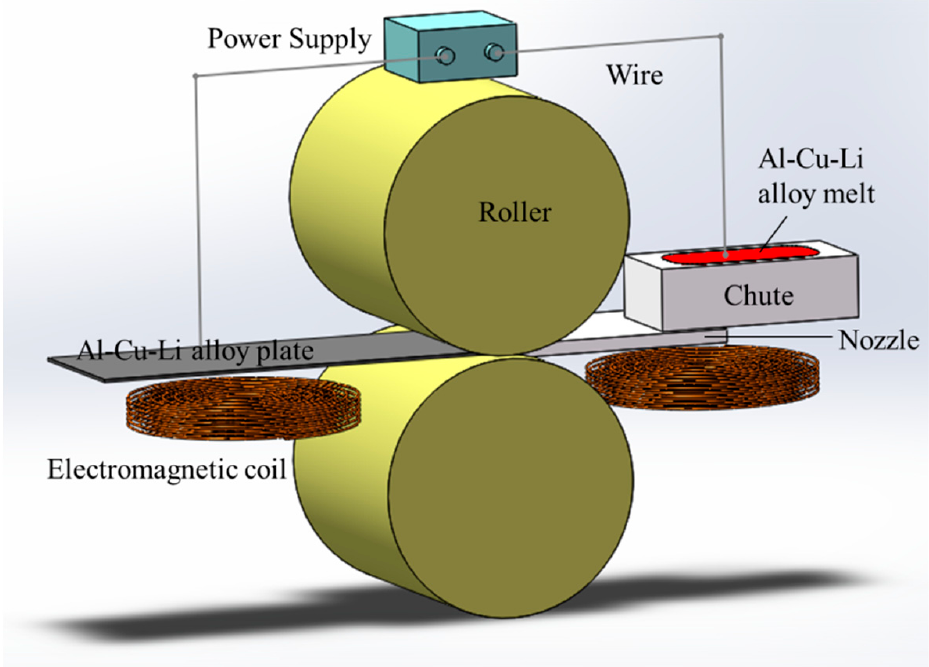
Figure 1. Sketch map of the electromagnetic TRC technique. The corresponding boundary conditions of the electromagnetic TRC process were as shown